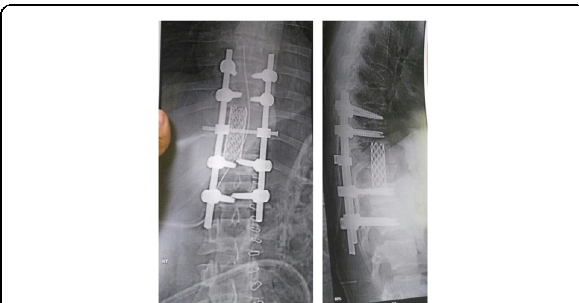
Fig. 12 Postoperative X-ray spine AP and lateral in the same patient (case